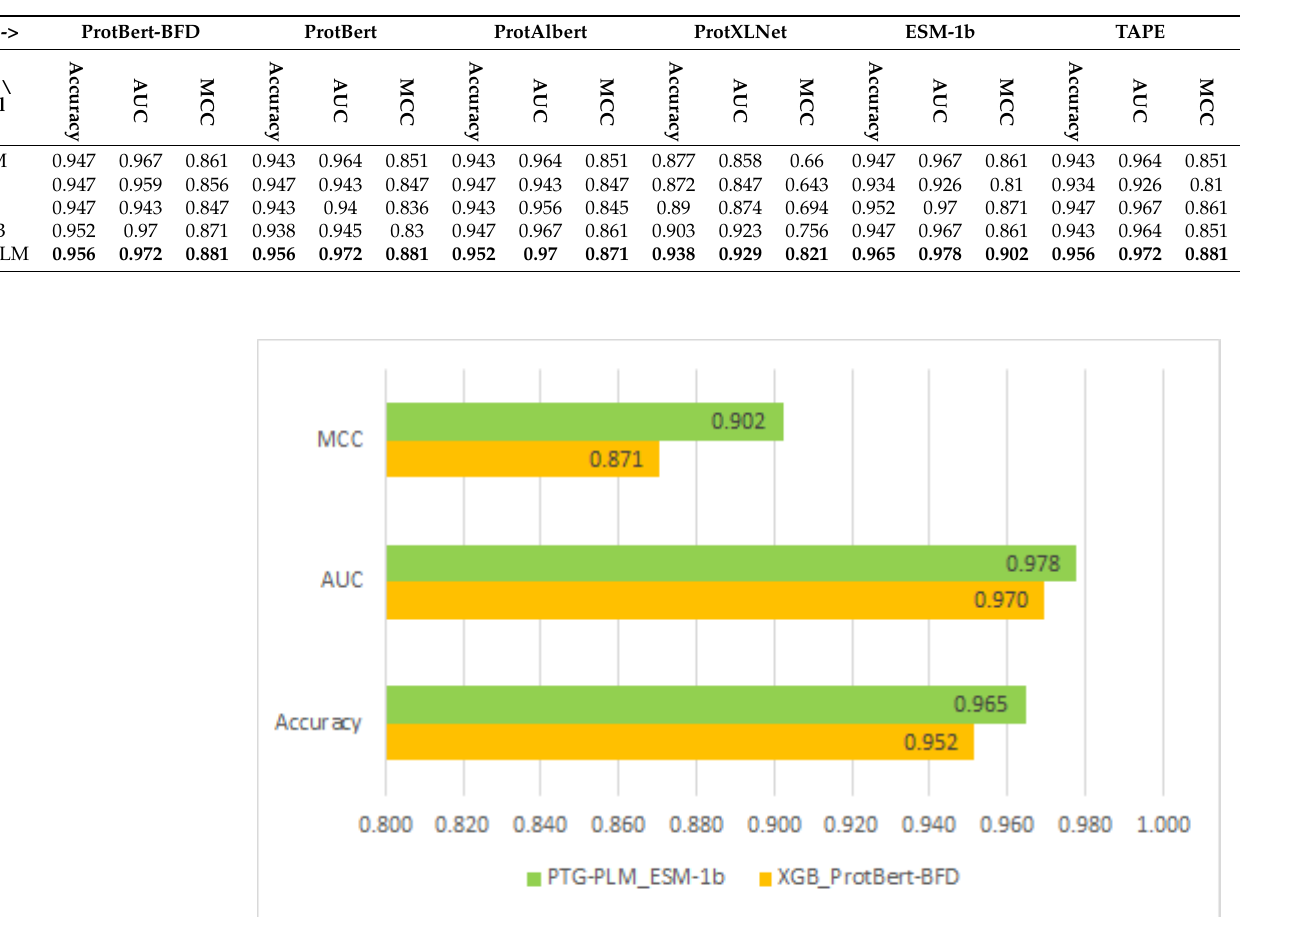
Figure 5. Comparison of performance between the best PTG-PLM model (based on ESM-1b) and best-supervised learning model (XBG based on ProtBert-BFD) on the Ngly independent dataset. Based on the Kgly independent set, the PTG-PLM is also compared with the four supervised learning based on the embedding features extracted using the six PLMs. Table 8 shows the comparative performance in terms of accuracy, AUC, and MCC. As shown in the table, the PTG-PLM outperforms the four supervised learning methods across all the PLMs. Furthermore, PTG-PLM with the ProtBert-BFD PLM has the best performance on the Kgly independent dataset with a 0.641 accuracy, 0.641 AUC, and 0.282 MCC. When comparing the four supervised learning methods, SVM with the ProtBert-BFD PLM has the highest performance on the Kgly independent dataset with a 0.631 accuracy, 0.631 AUC, and 0.261 MCC. The comparison of performance between the two best models, PTG-PLM with the ProtBert-BFD and SVM with the ProtBert-BFD, on the Kgly dataset is shown in Figure